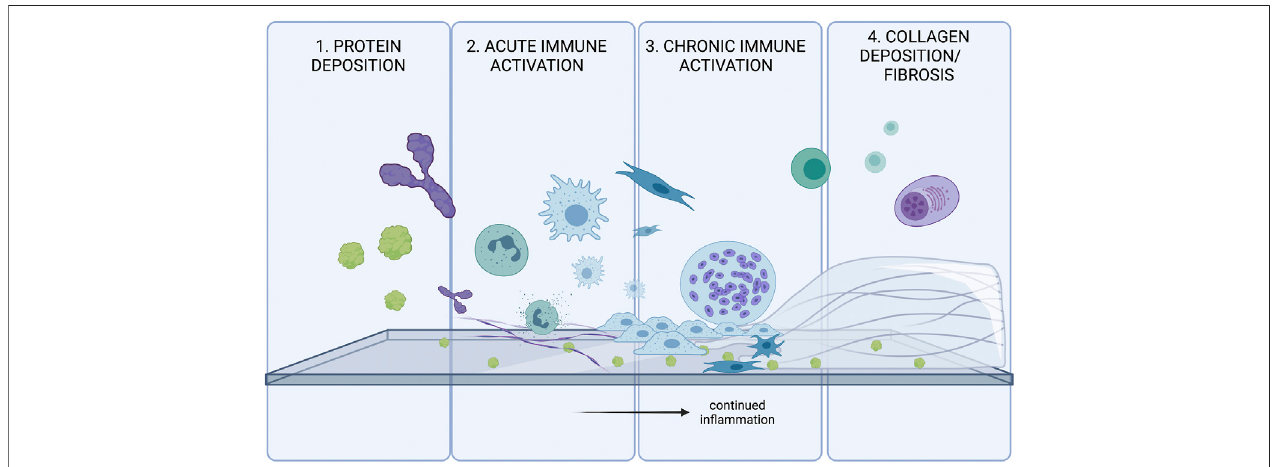
FIGURE 1 | The four stages of the Foreign Body Response (FBR). FBR is initially triggered by protein adsorption. and activation of various in fl ammatory cascades. Innate immune systemsattempt todegrade/phagocytose theforeignbody,and will continue totryeliminating thethreatuntil collagen accumulates onthe surfaceofthe foreign body. The fi brosis acts as a barrier to protect the body from the threat of the foreign